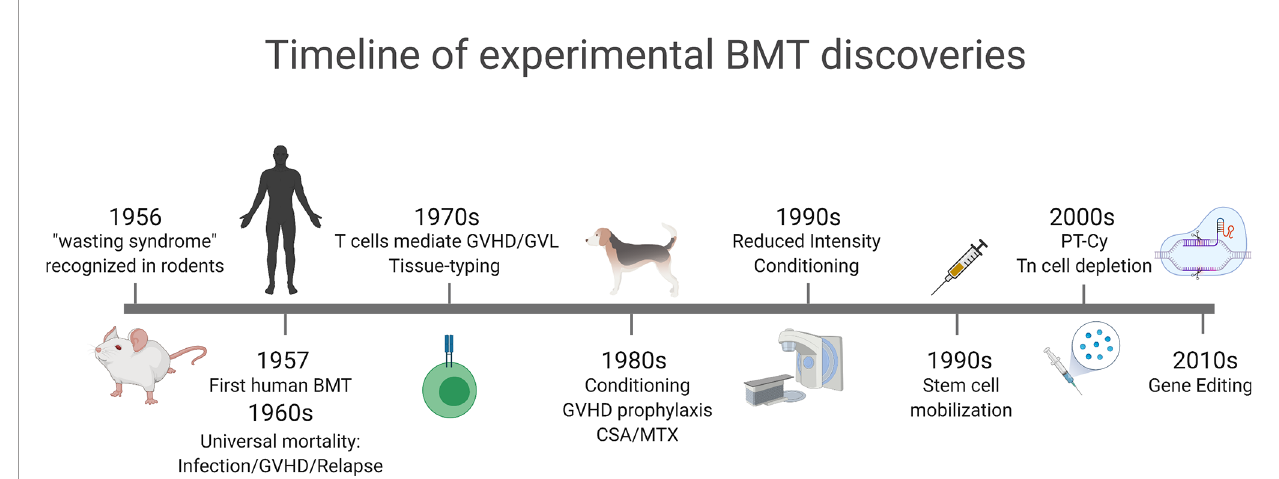
FIGURE 1 | Timeline of major experimental concepts that have translated into clinical practice. GVHD was initially described as a wasting syndrome in transplanted mice in 1956. Early clinical bone marrow transplantation was associated with high mortality due to GVHD, infection and relapse. Recognition of T cells as the mediators of GVHD and GVL and initiating rudimentary tissue-typing. Conditioning and GVHD prophylaxis regimens were developed in dog models in the 1980s that led to reduced intensity and non-myeloablative conditioning in the 1990s. Stem cell mobilization following cytokine administration was developed in the early 1990s and gained widespread clinical translation. New approaches to GVHD prophylaxis, including post-transplant cyclophosphamide (PT-Cy) and naïve T (Tn) cell depletion developed in the 2000s and are increasingly utilized in the clinic. In the last decade the widespread use of gene editing, initially in T cells, has been widely translated to modulate GVHD and GVL. Figure generated with